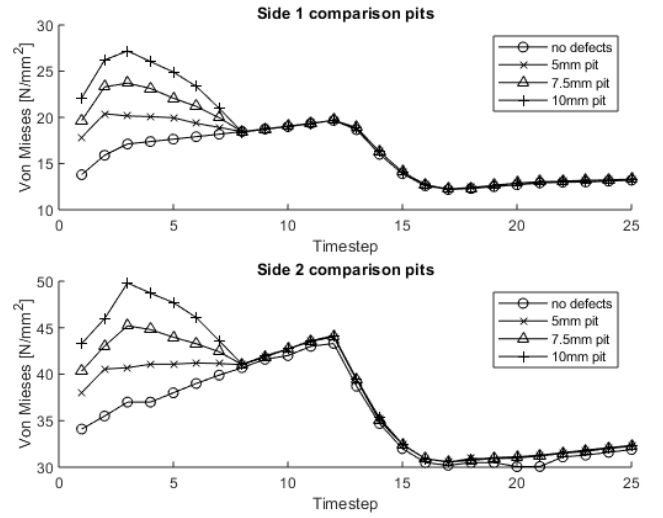
Figure 10. Comparison of all the simulations performed, side 1 ( Top ) side 2 ( Bottom ).